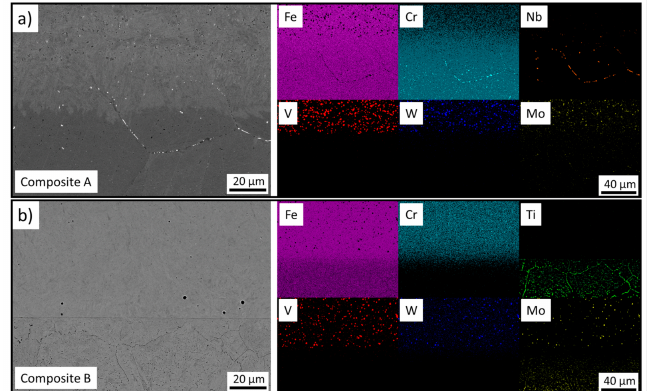
Figure 7. Backscattered electron images of the interface with EDX mappings of the interface for various element distributions: ( a ) composite A, ( b ) composite B. The distribution of carbides in the vicinity of the interface can be observed. No di ff usion of substitutionally dissolved elements can be